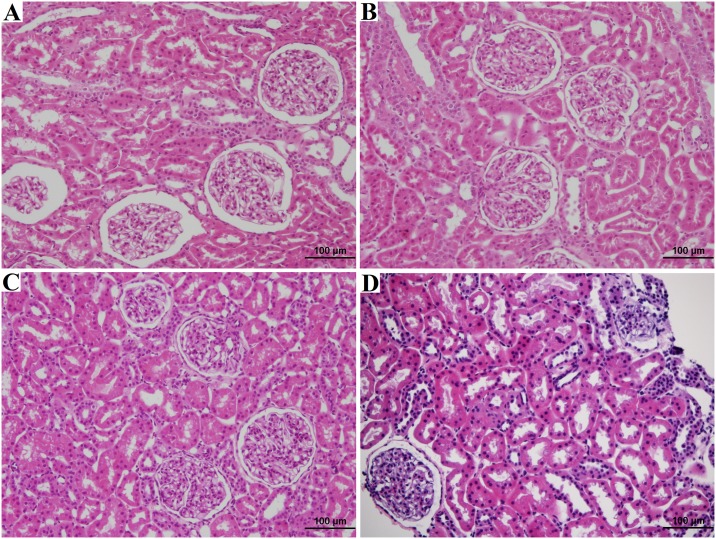
Kidney H&E analysis.Biopsy A shows Kidney H&E of naïve rhesus, age 18 years, diagnosed as normal. Biopsy B shows Kidney H&E of naïve rhesus, age 15 years, diagnosed with mild acute tubular injury, focal mild arteriosclerosis. Biospy C shows Kidney H&E of brain dead rhesus, age 16 years, diagnosed normal. Biopsy D shows Kidney H&E of naïve rhesus, age 19 years, diagnosed with mild acute tubular injury, focal mild arteriosclerosis.